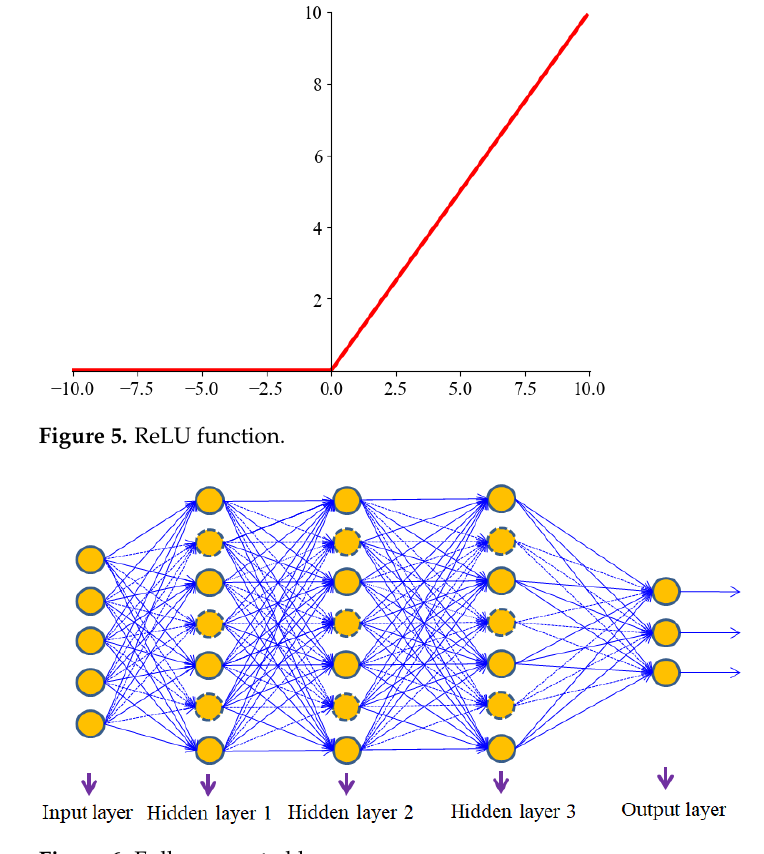
Figure 6. Fully connected layer.